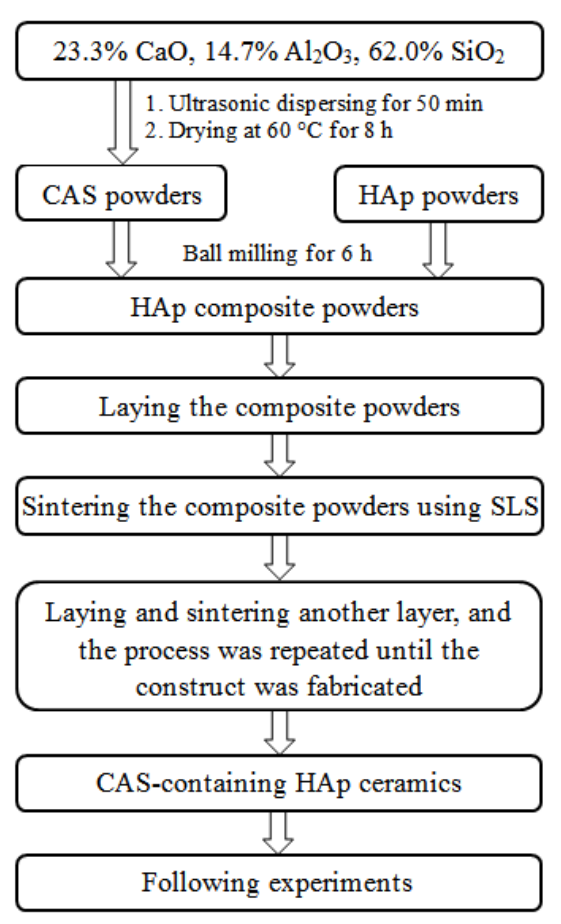
Figure 7. Scheme for the preparation of CAS-containing